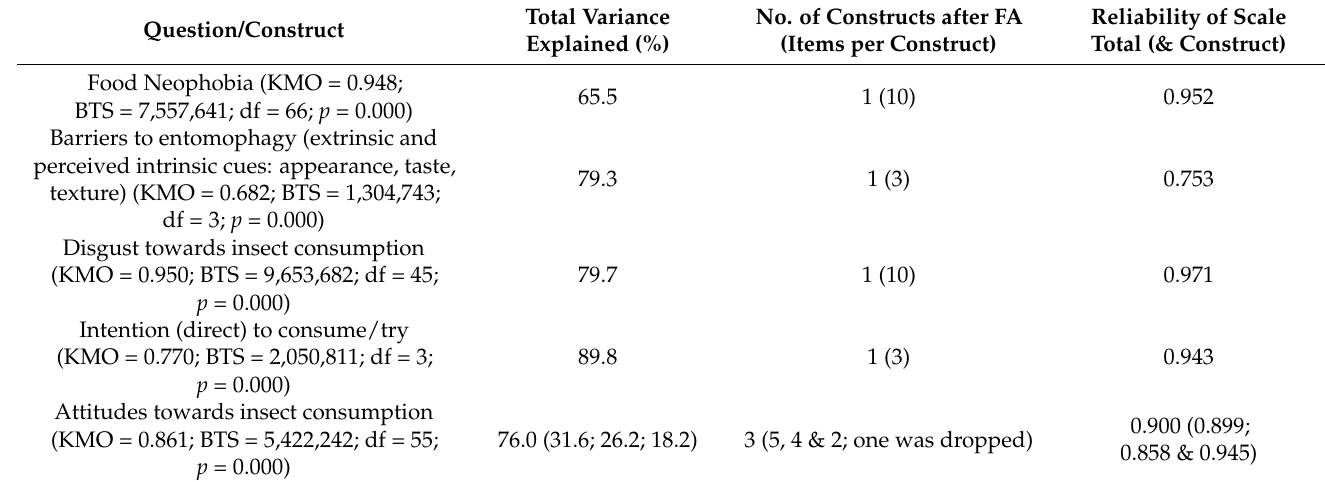
Table 4. Constructs and Reliability of